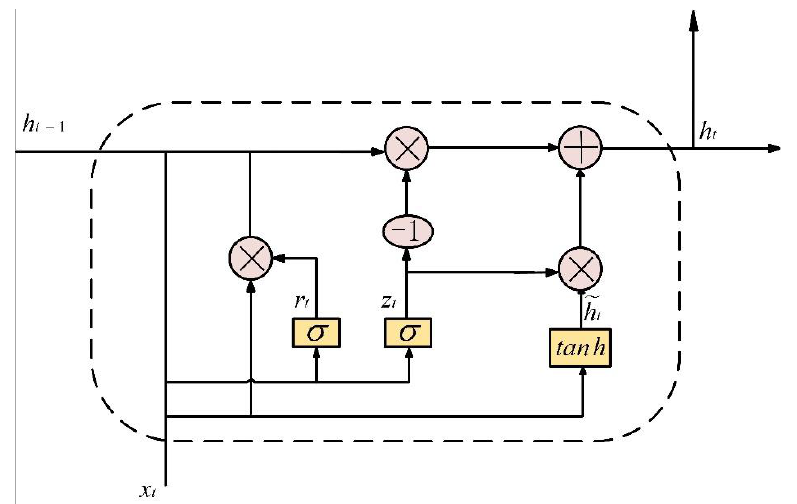
Figure 3. GRU model structure.